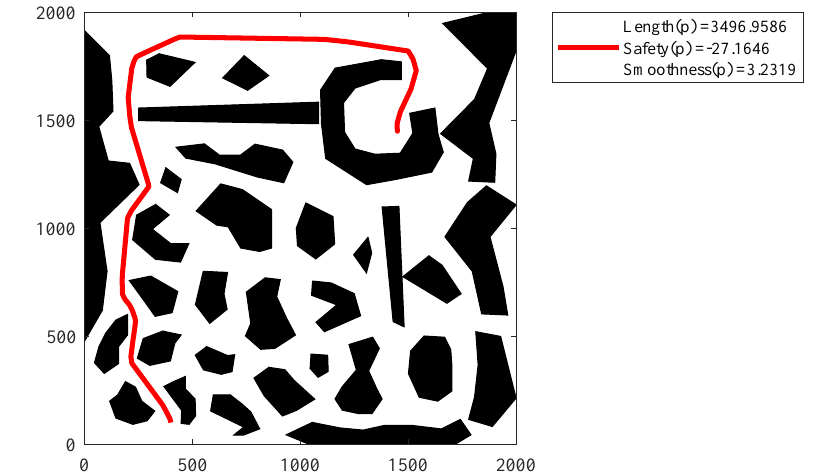
Figure 15. Graphical solution for the Figure 8B with MOEA.